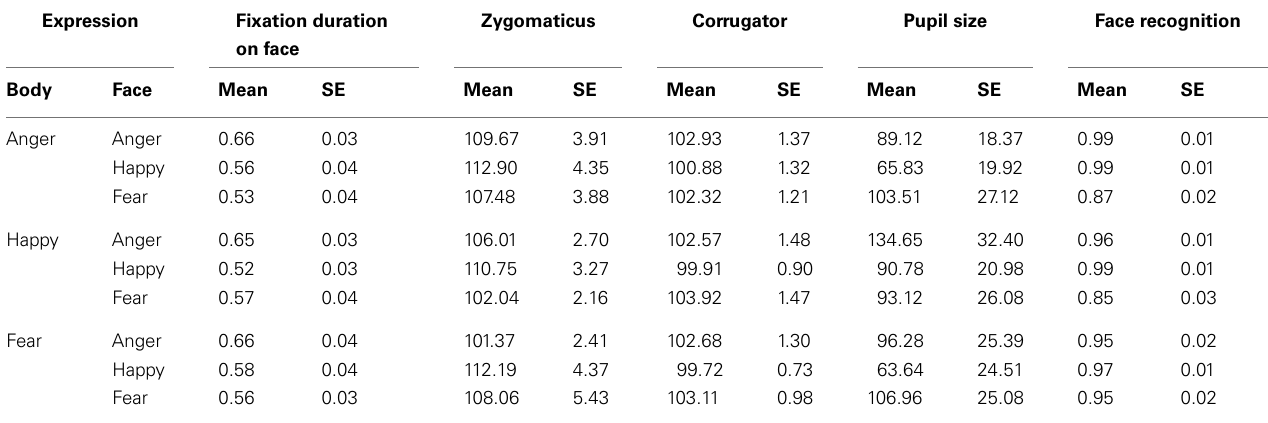
Table 1 | Means and standard